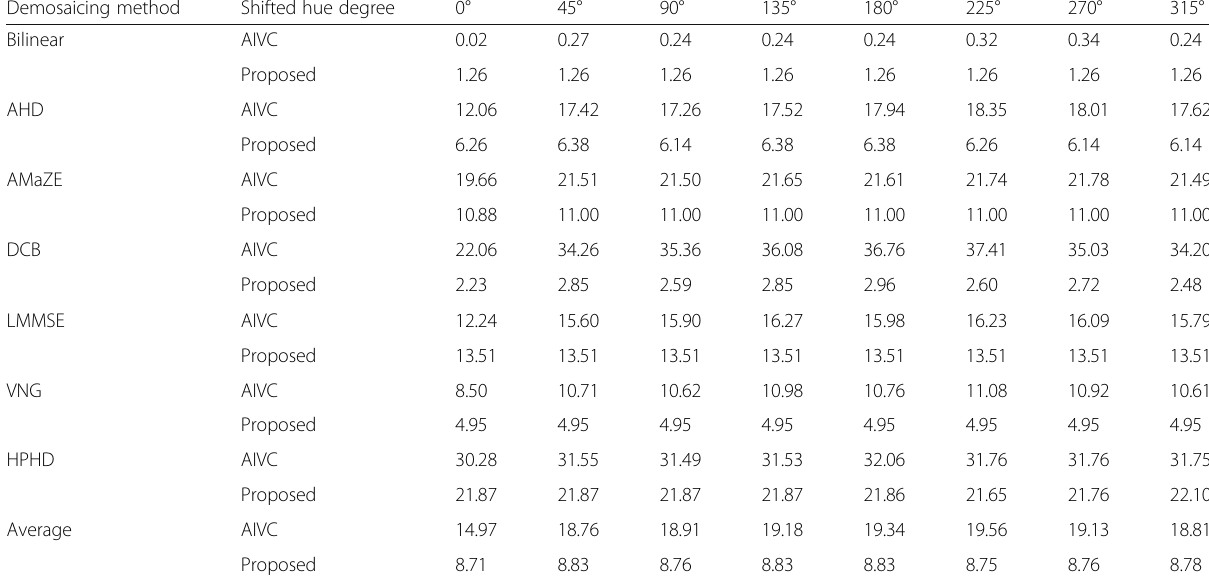
Table 3 Mean error value comparison between AIVC and the proposed method for various demosaicing methods and shifted hue angles in a 256 × 256 centered block Demosaicing method